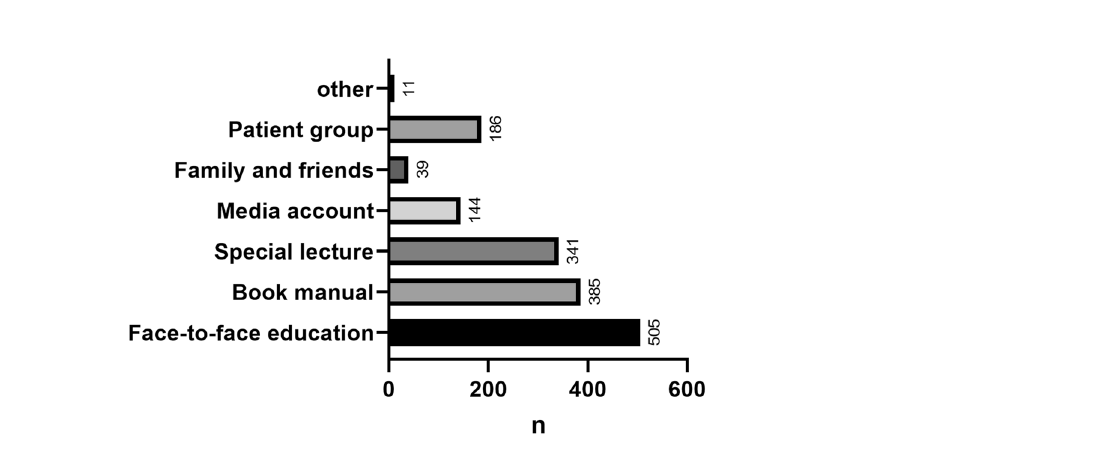
Figure 2. The main source of IBD